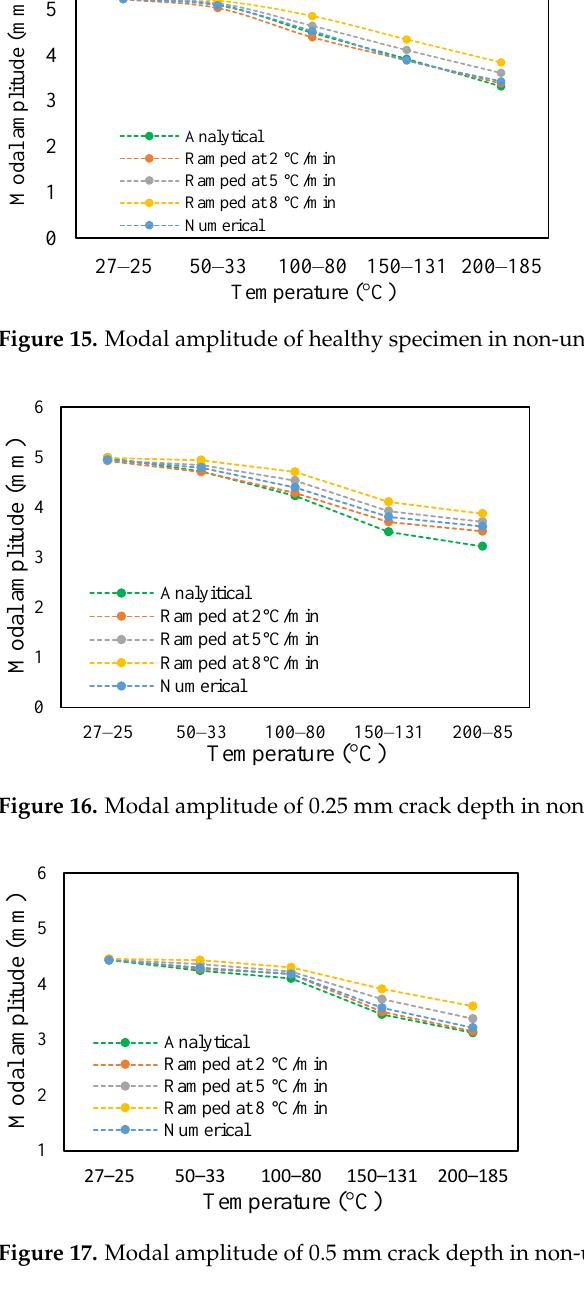
Figure 18. Modal amplitude of 1 mm crack depth in non-uniform temperature.